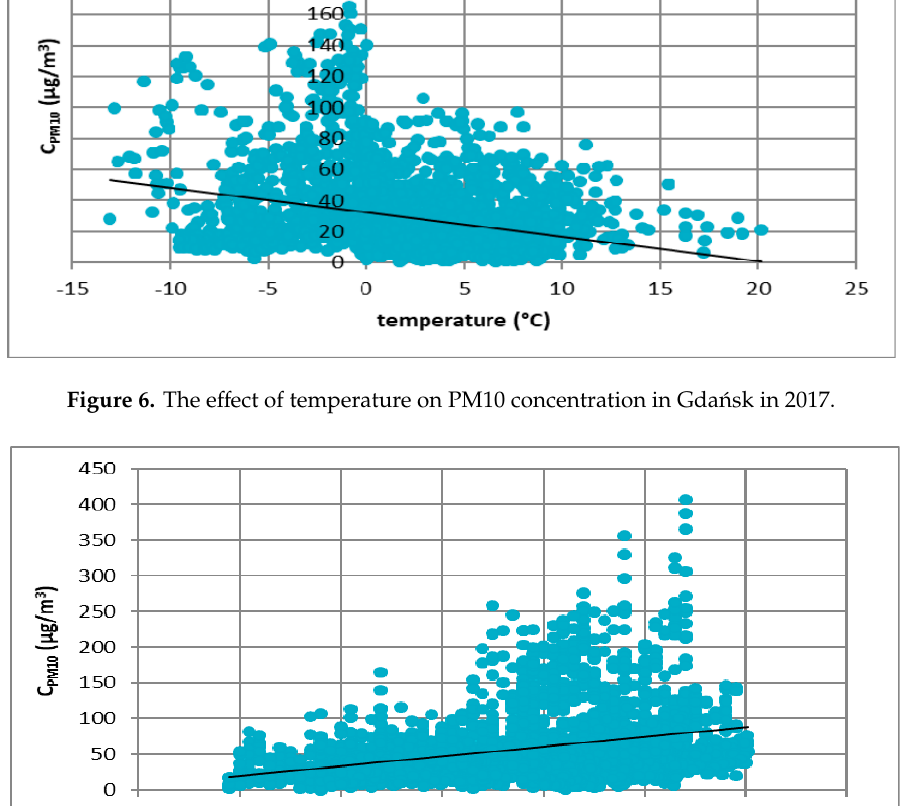
Figure 8. The effect of atmospheric pressure on PM10 concentration in Kraków in 2017.